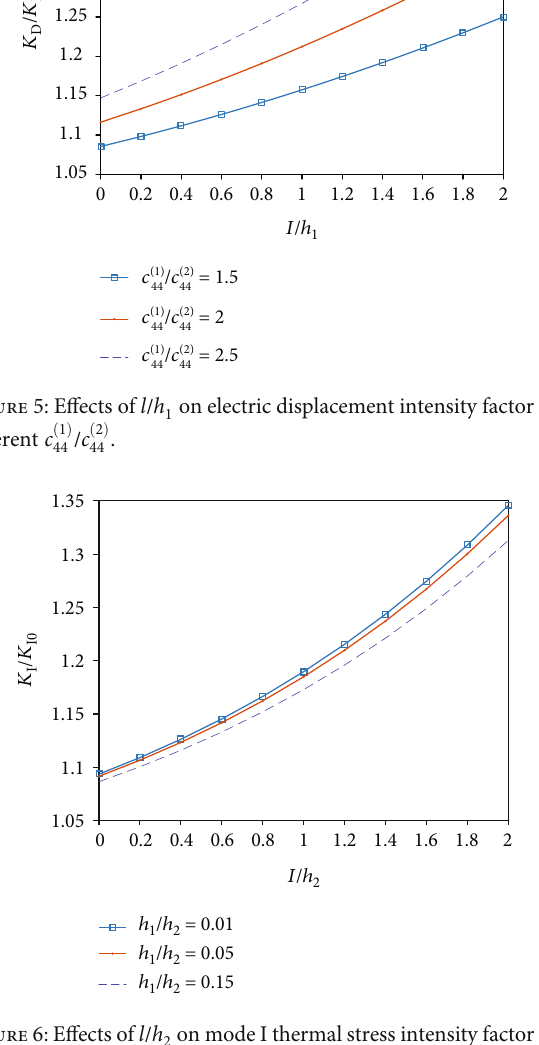
Figure 4: E ff ects of l / h for di ff erent c